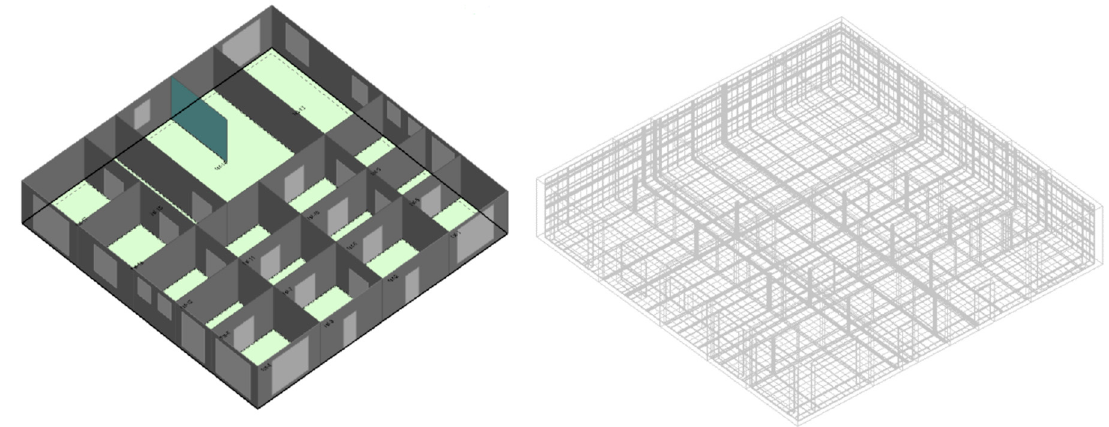
Figure 10. Computational domain and the surface grid of the CFD model.